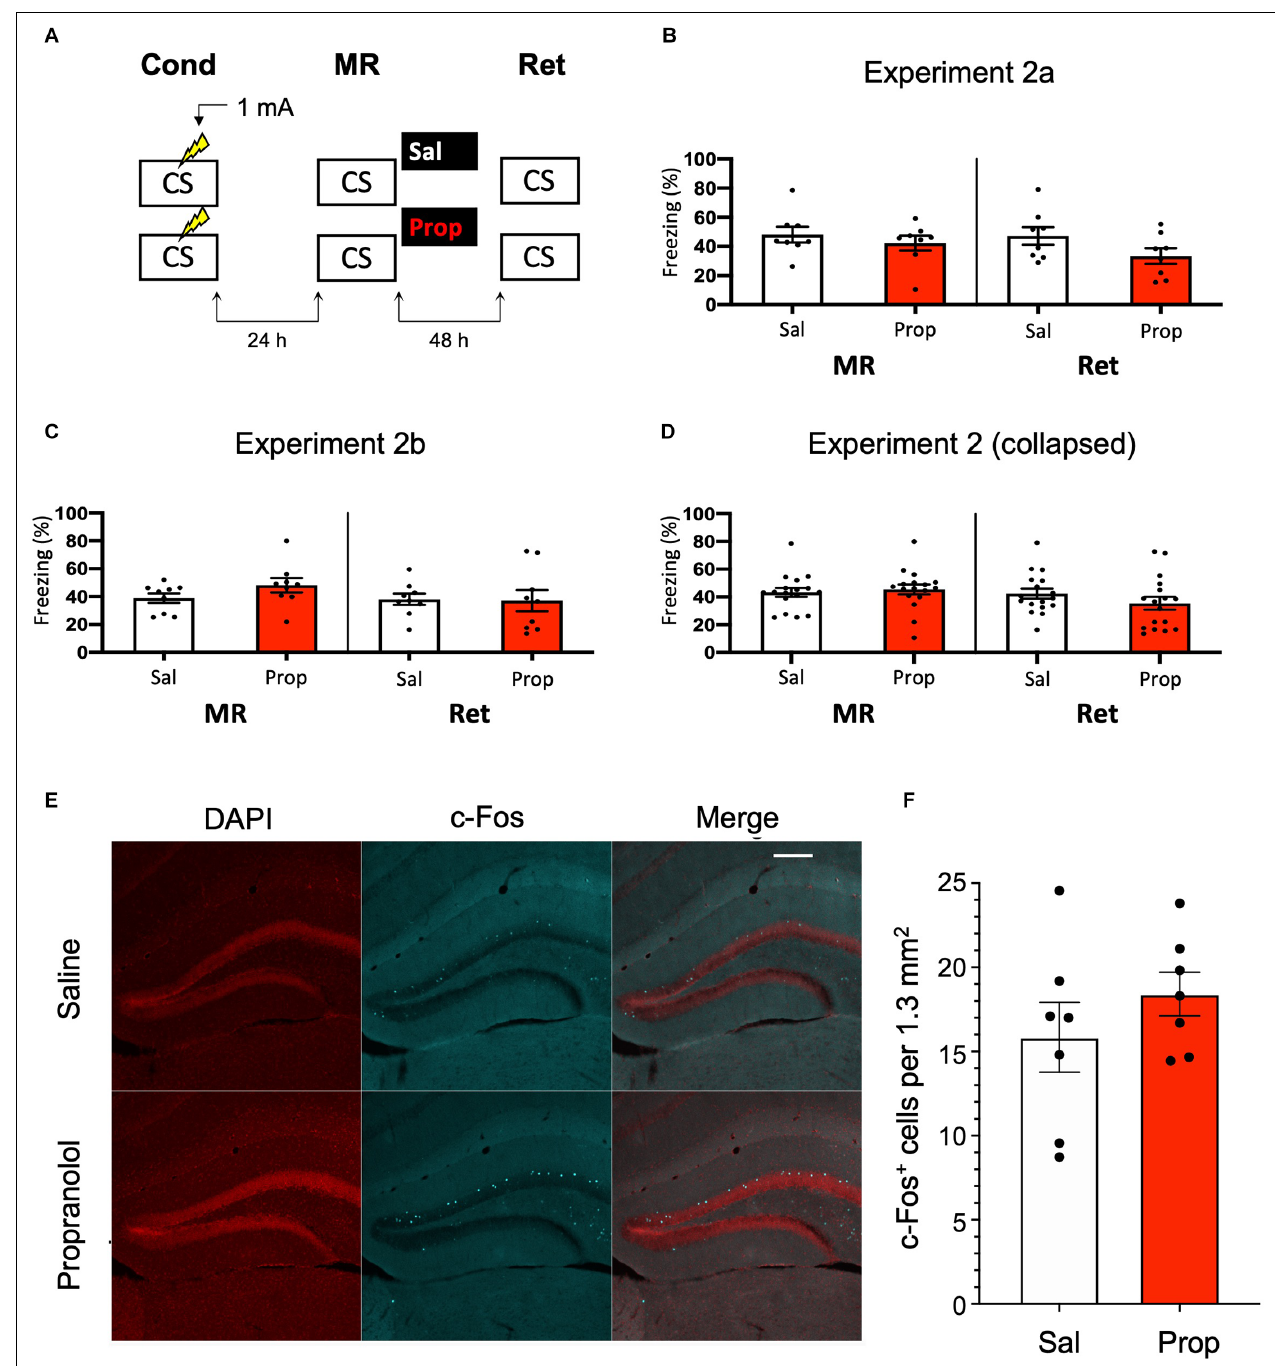
FIGURE 2 | A minor effect of propranolol on reactivated memories that were acquired with a single 1 mA shock during contextual fear conditioning. (A) Design of Experiment 2a. Mice received one 1 mA shock during fear conditioning. One day later, saline ( n = 8) or propranolol ( n = 8) was administered after memory reactivation. Forty-eight hours afterwards, retention of contextual fear was assessed. Cond, conditioning; MR, memory reactivation; Ret, retention; CS, conditioned stimulus (context); Sal, saline; Prop, propranolol. (B) Results of Experiment 2a. Average percentage of freezing during memory reactivation is displayed on the left, and freezing during the retention test on the right panel of the column chart (saline in white bars, propranolol in red bars). Error bars represent SEM. Filled circles indicate individual animals. (C) Results of Experiment 2b (saline, n = 9; propranolol, n = 9). Experiment 2b was a direct replication of Experiment 2a. (D) Collapsed results of Experiment 2a and Experiment 2b. (E) Representative images of the DG 90 min after the retention test from mice that received either saline ( n = 7), or propranolol ( n = 7) post-reactivation (Experiment 2a). Cells that were c-Fos + are labeled in cyan (scale bar: 200 µ m). (F) Number of c-Fos + cells in the DG per 1.3 mm 2 . Error bars represent SEM. Filled circles indicate individual